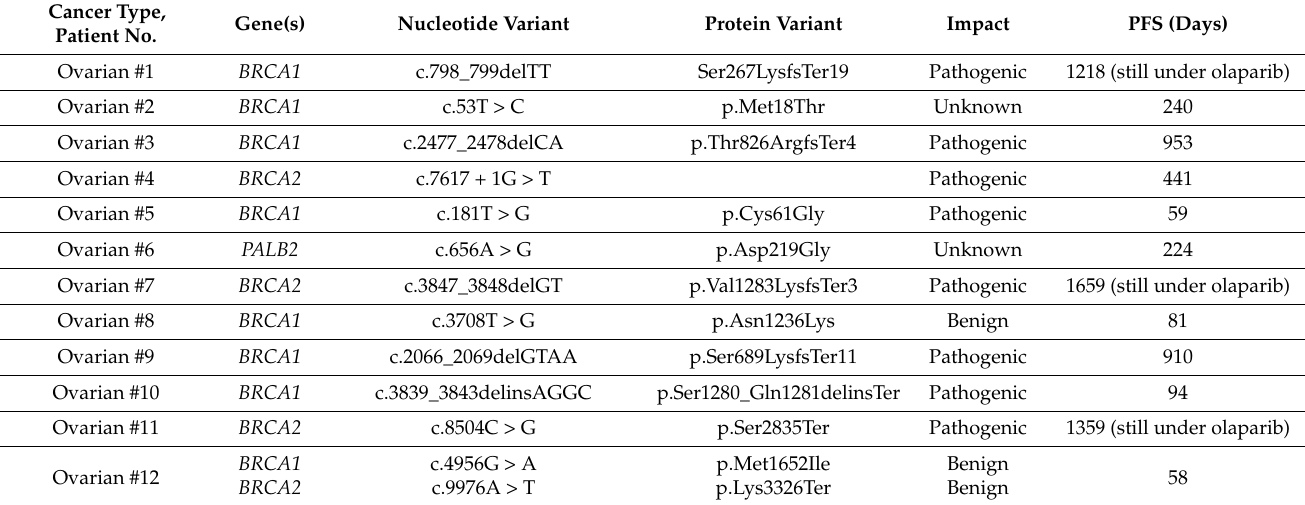
Table 2. List of variants observed in our population of 41